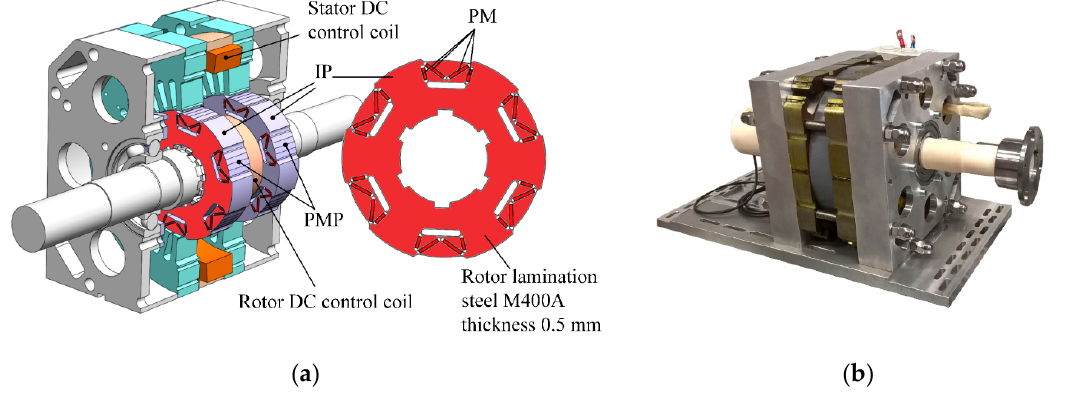
Figure 3. ECPMS-machine design: ( a ) Design; ( b ) Prototype [54].